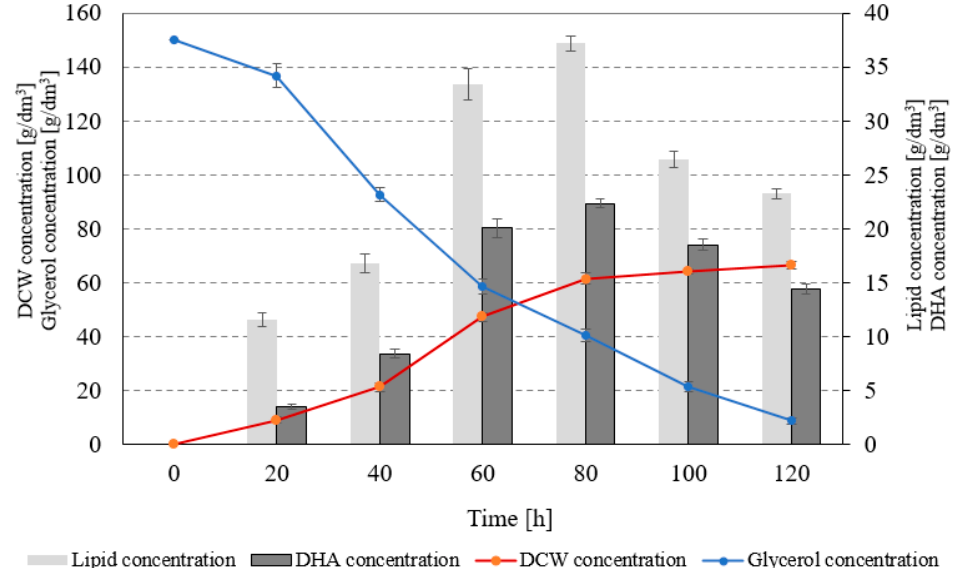
Figure 1. Changes in DCW concentration, lipid concentration, and DHA concentration in Schizochytrium sp. biomass and changes in glycerol concentration in the culture medium during the batch culture.